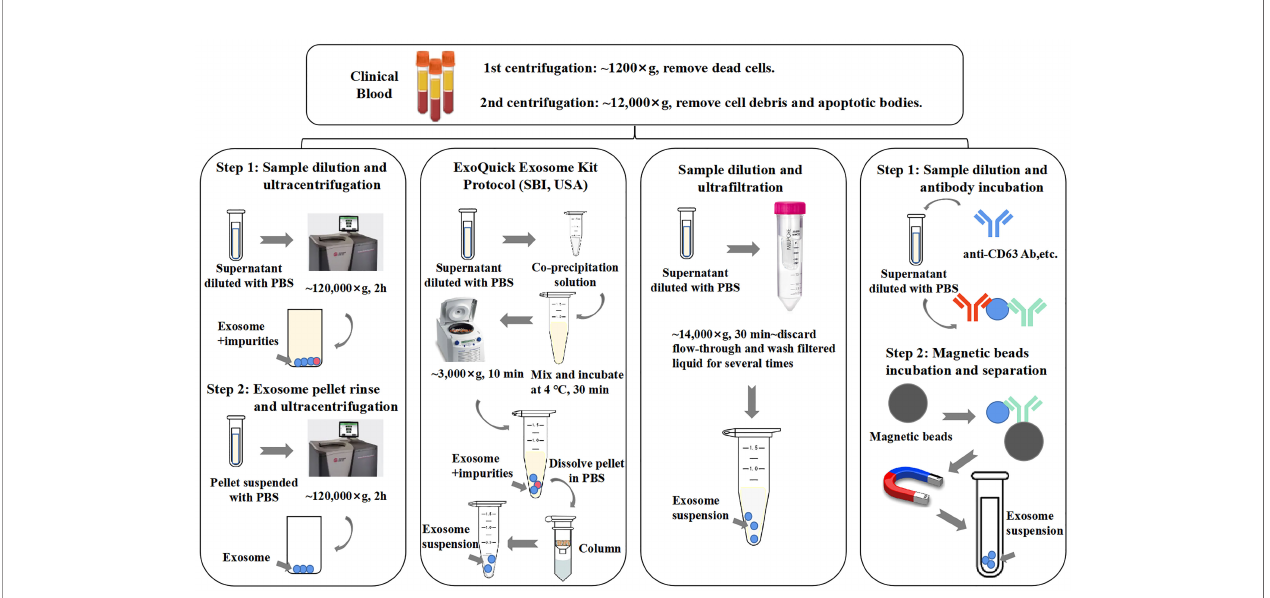
FIGURE 2 | General procedures of different exosome isolation methods. Experimental conditions and operating processes of ultracentrifugation, PEG co-precipitation (ExoQuick Kit, SBI, USA), ultra fi ltration, and immunoaf fi nity are shown in the top panels from left to right. During preparation procedures, blood samples (plasma/serum) would undergo two rounds of low-speed centrifugation, the pellet of each round is deserted, and the supernatant of fi nal round is diluted with phosphate-buffered saline (PBS) for better